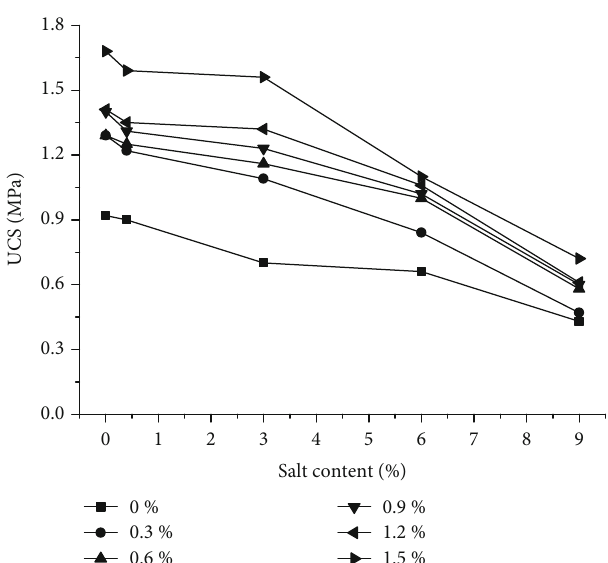
Figure 5: In fl uence of the salt content on the UCS for di ff erent ZM concentrations after a curing period of seven